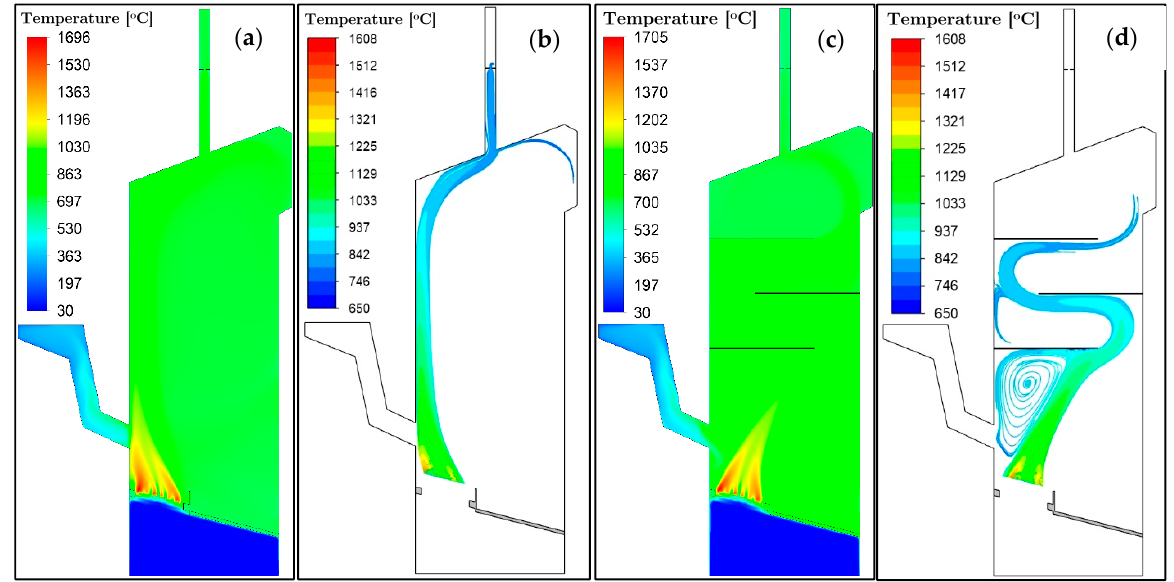
Figure 9. Gas temperature distribution ( a , c ) and particle path lines colored by particles temperature ( b , d ) for the system without (Exp 1) and with baffles (Exp 4).